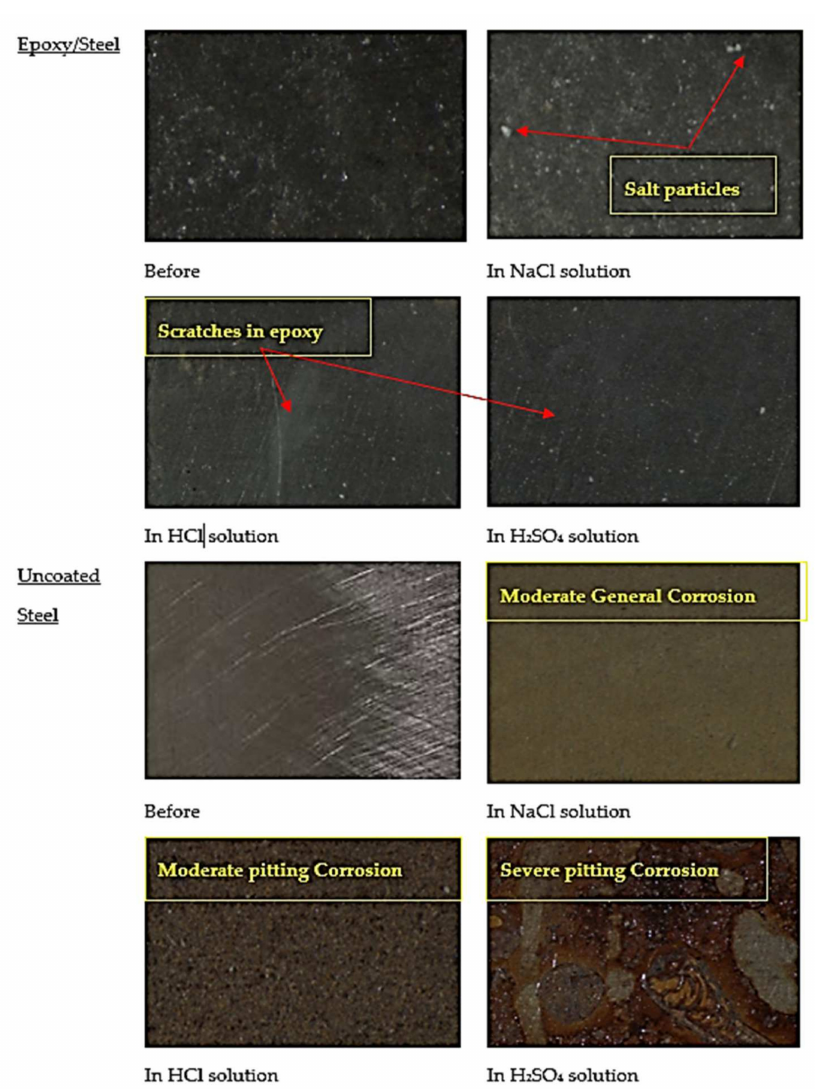
Figure 14. Optical microscope images for the tested specimens before and after the electrochemical